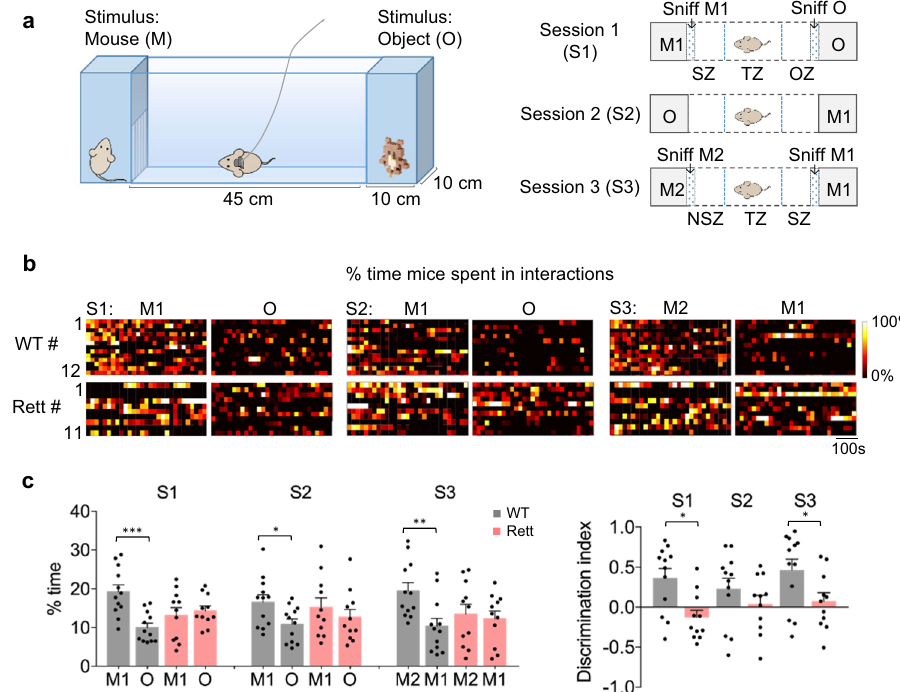
Fig. 1 Female Rett mice display social de fi cits in social interaction test. a Left: the apparatus for the social interaction test. The subject mouse is in the middle 40 cm-long chamber; the 10 cm end compartments contain different stimuli. Right: the three sessions of the social interaction test. In the fi rst 10 minute test session (S1), a strange mouse (M1) and an object (O) were placed in the end chambers; session 2 (S2) used the same stimuli but swapped their positions; in session 3 (S3) a new mouse (M2) replaced O, so that the subject mouse must choose whether to interact with a familiar or strange mouse (M1 vs. M2). “ Sniff ” means the mouse was at the end of the chamber and interacting with a stimulus; social zone (SZ), object zone (OZ), and new social zone (NSZ) indicate the 10 cm regions of the central chamber that are nearest to the end chambers of M1, O, and M2, respectively; transition zone (TZ) means the middle area in the central chamber. b Raster plots of the percentage of time mice spent in interacting with different stimuli in 3 – 10 minute sessions. The time is divided into 20 second bins; the color ranges from deep red (0%) to yellow (100%). c Left: the percentage of time that WT ( Mecp2 + / + ; n = 12) and Rett ( Mecp2 + / − ; n = 11) mice spent interacting with stimuli in each session. Right: Discrimination Iindices of WT and Rett mice indicating the difference in the amount of time the mice spent with each stimulus in a given session (M1 vs. O in S1 and S2; M2 vs. M1 in S3), relative to the total duration of stimulus interactions out of the whole session. Data are represented as mean ± SEM. * P < 0.05, ** P < 0.01, *** P < 0.001, two-way RM ANOVA with Bonferroni – corrected post hoc comparisons. Source data are provided as a Source Data fi